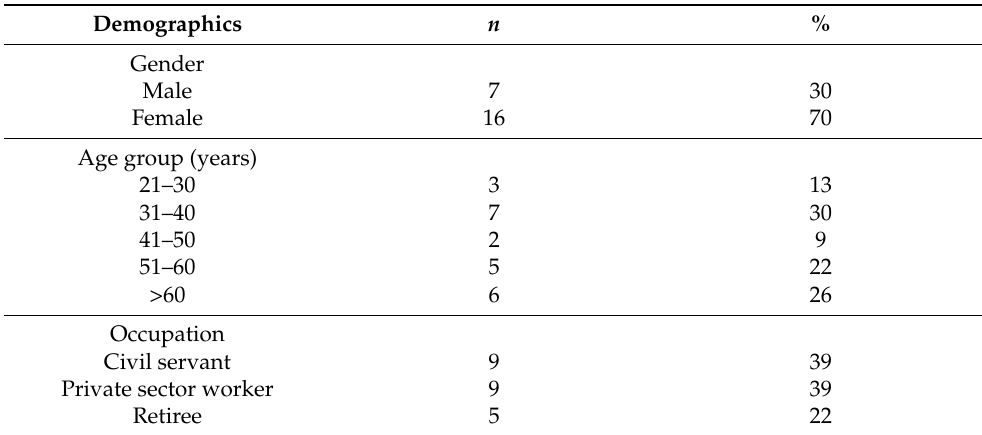
Table 1. Demographic characteristics of the study participants ( n = 23).